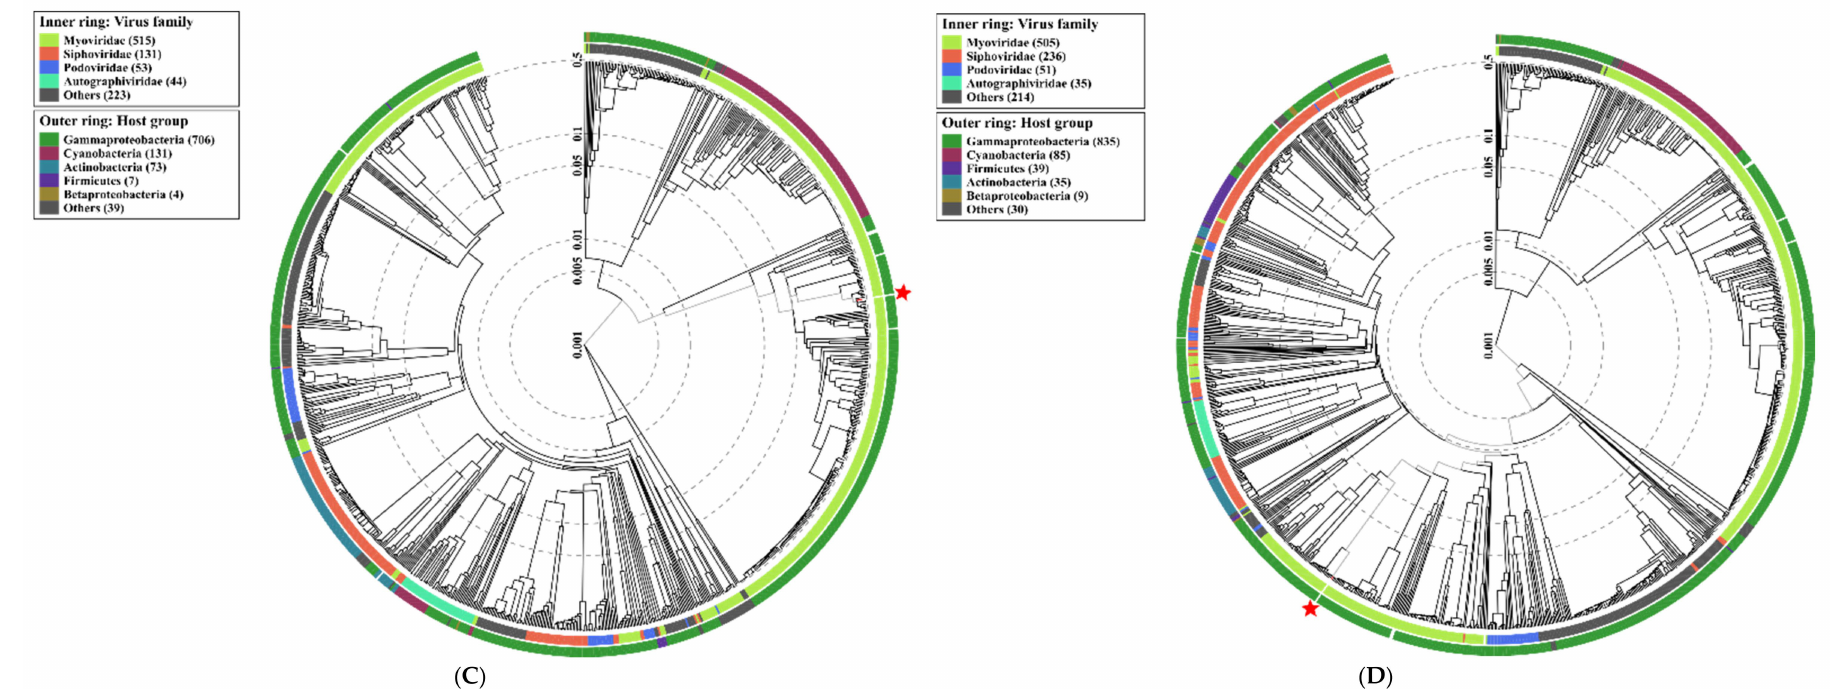
Figure 5. Viral proteomic trees of ( A ) Enterobacter phage KKP 3263, ( B ) Enterobacter phage KKP 3262, ( C ) Citrobacter phage KKP 3664, ( D ) Serratia phage KKP 3264, and other Autographiviridae and Myoviridae phage genomes are represented in the circular view. The branch represented studied phages is marked by an asterisk. Color rings indicate virus families (inner rings) and host groups (at a level of phylum; outer rings). These trees were calculated by BIONJ based on genomic distance matrixes, and mid-point rooted. Branch lengths are log-scaled. The sequence and taxonomic data were based on Virus-Host DB [83]. The shown trees were generated using the ViPTree server